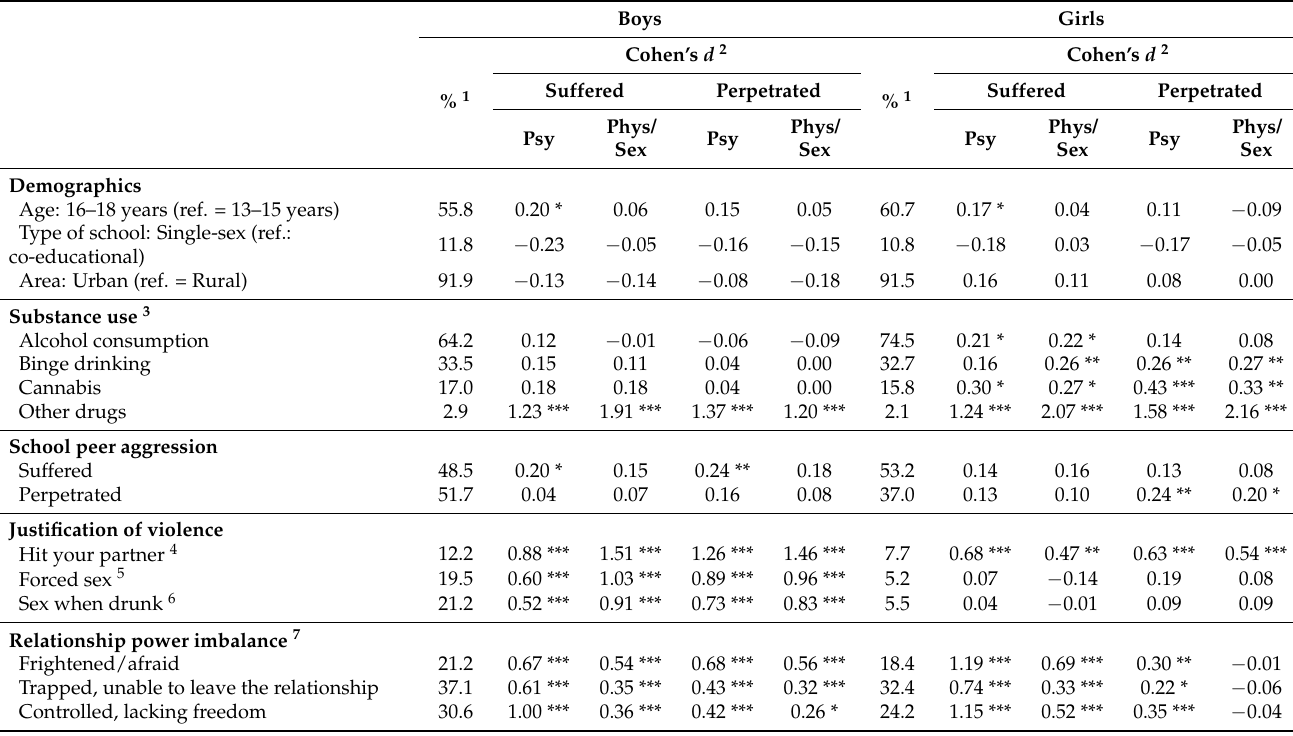
Table 4. Differences in the adolescent dating violence (ADV) subscales across groups defined by some predictor variables, stratified by sex. Boys